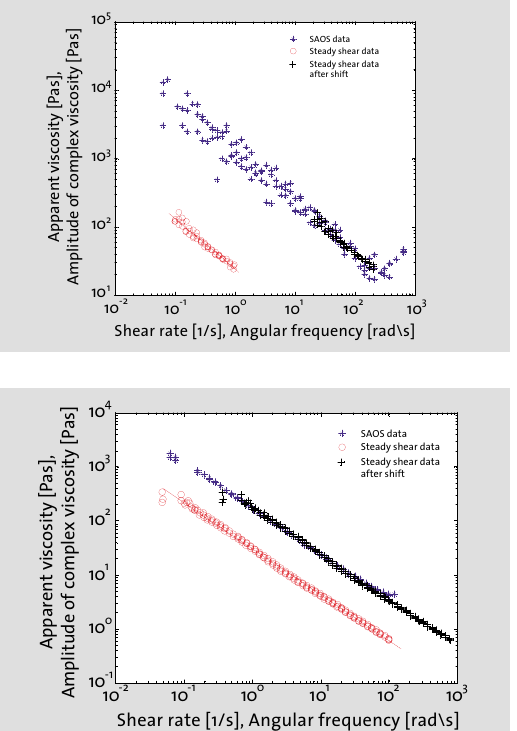
Figure 2 (left above): Steady shear flow and SAOS data for condensed milk at 30˚C. Figure 3 (right above): Steady shear flow and SAOS data for mayon- naise at 30˚C. Figure 4 (left below): Steady shear flow and SAOS data for ketchup at 30˚C. Figure 5 (right below): Steady shear flow and SAOS data for cream cheese at 30˚C.